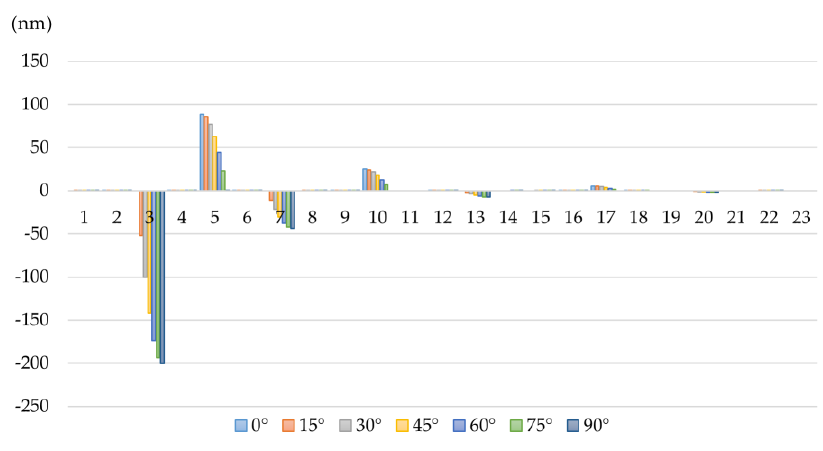
Figure 14. Aberration variation of optical surface.